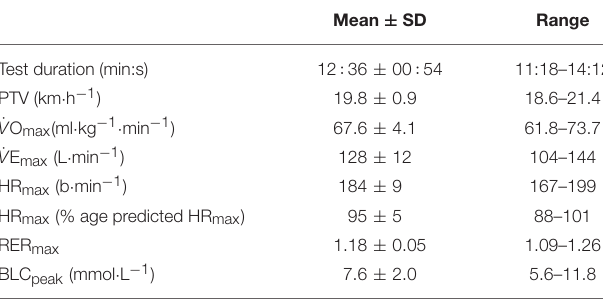
TABLE 2 | Maximal values attained during the maximal ramp incremental running test ( n = 13).